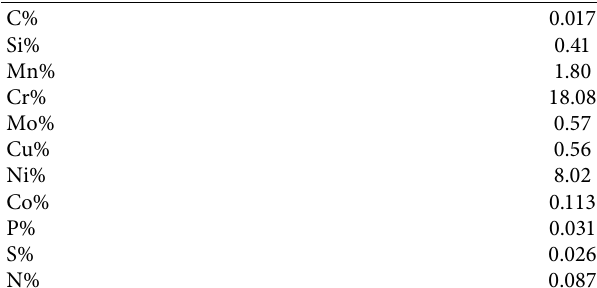
Figure 1: (a) Component 3D model and (b) detail 2D drawing. Table 1: Chemical composition. Table 2: Technical specification of the ULTRACUT